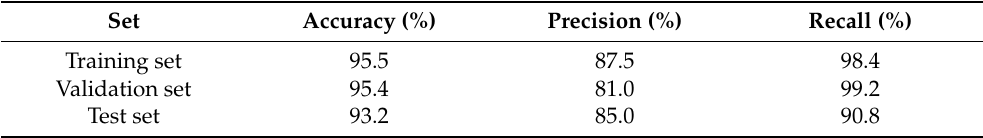
Table 3. Evaluation scores of training, validation, and test set of GRU-based zero-velocity